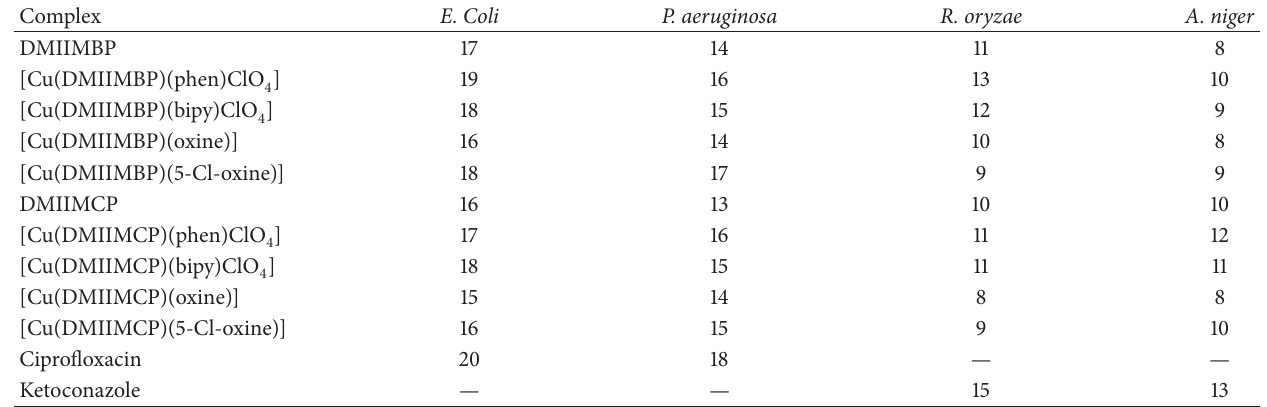
Table 7: Antimicrobial activity of the Schiff bases and metal complexes.